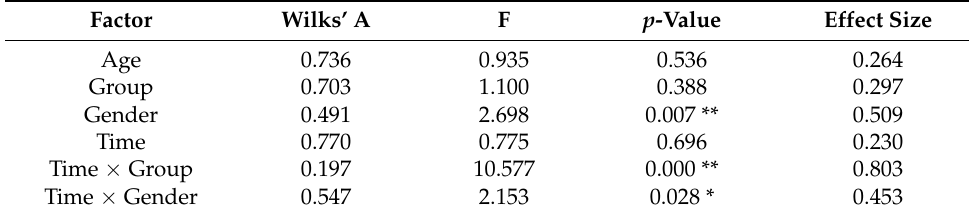
Table 2. Repeated measures MANOVA (Multivariate analysis of variance).